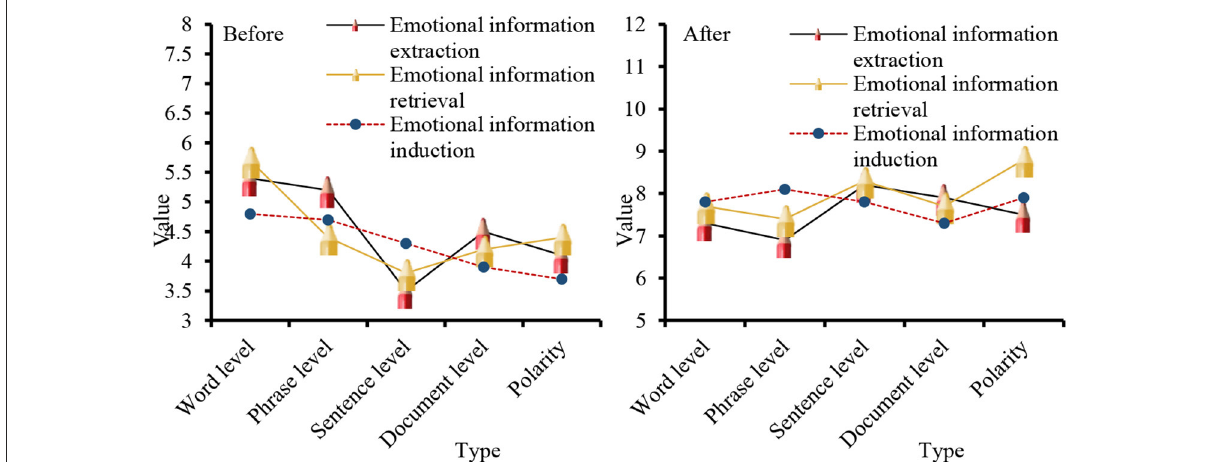
FIGURE8 Classification task statistics.